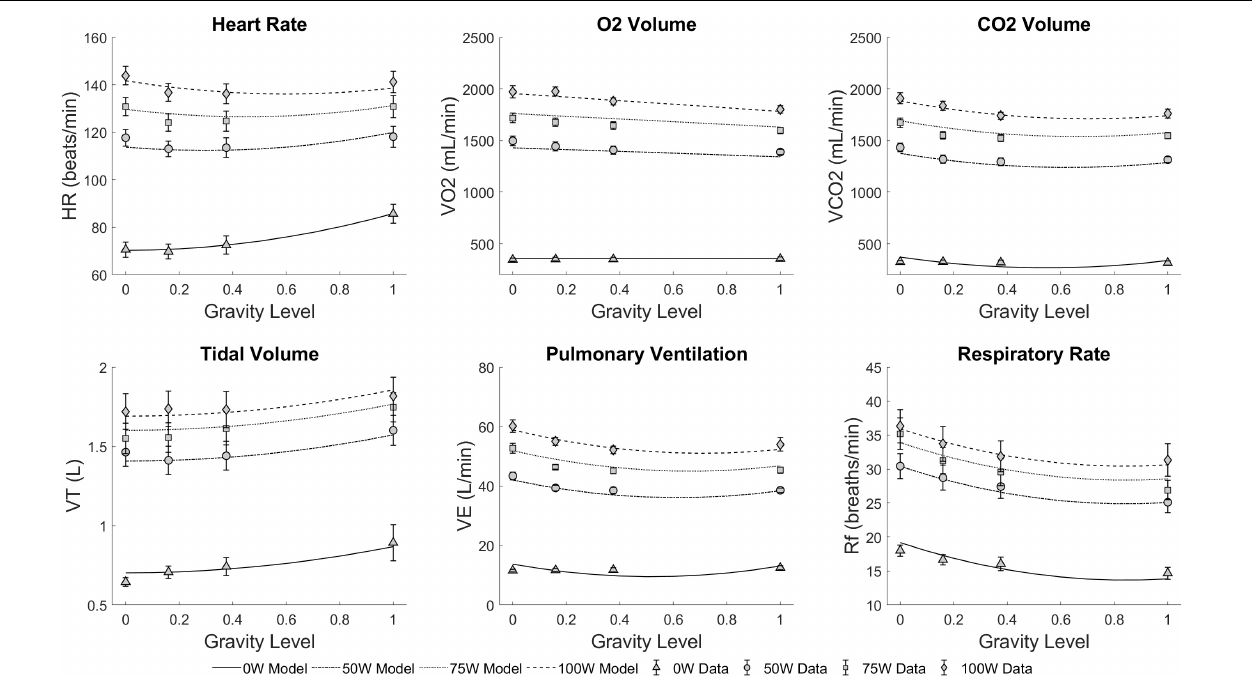
FIGURE 6 | Statistically significant regression models fitted to the cardiopulmonary experimental data across all conditions: four altered-gravity levels (Microgravity − 6 ◦ HDT, Moon + 9.5 ◦ HUT, Mars + 22.3 ◦ HUT, Earth + 90 ◦ upright) and four workload intensities (0, 50, 75, and 100W). Symbols and error bars correspond to experimental data from 14 subjects (mean ± SE) at each condition. TABLE 3 | Calculated minimum and maximum foot force averages [mean (SE), including 12 subjects] during each work rate of the exercise protocol (50W, 75W, 100W) at the different simulated altered-gravity positions (Microgravity − 6 ◦ HDT, Moon + 9.5 ◦ HUT, Mars + 22.3 ◦ HUT, Earth + 90 ◦ upright). Right Foot (N) Left Foot (N) Maximum Minimum